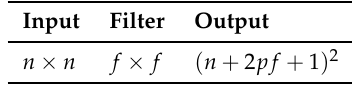
Table 2. Output Calculation for Convolutional Layer.